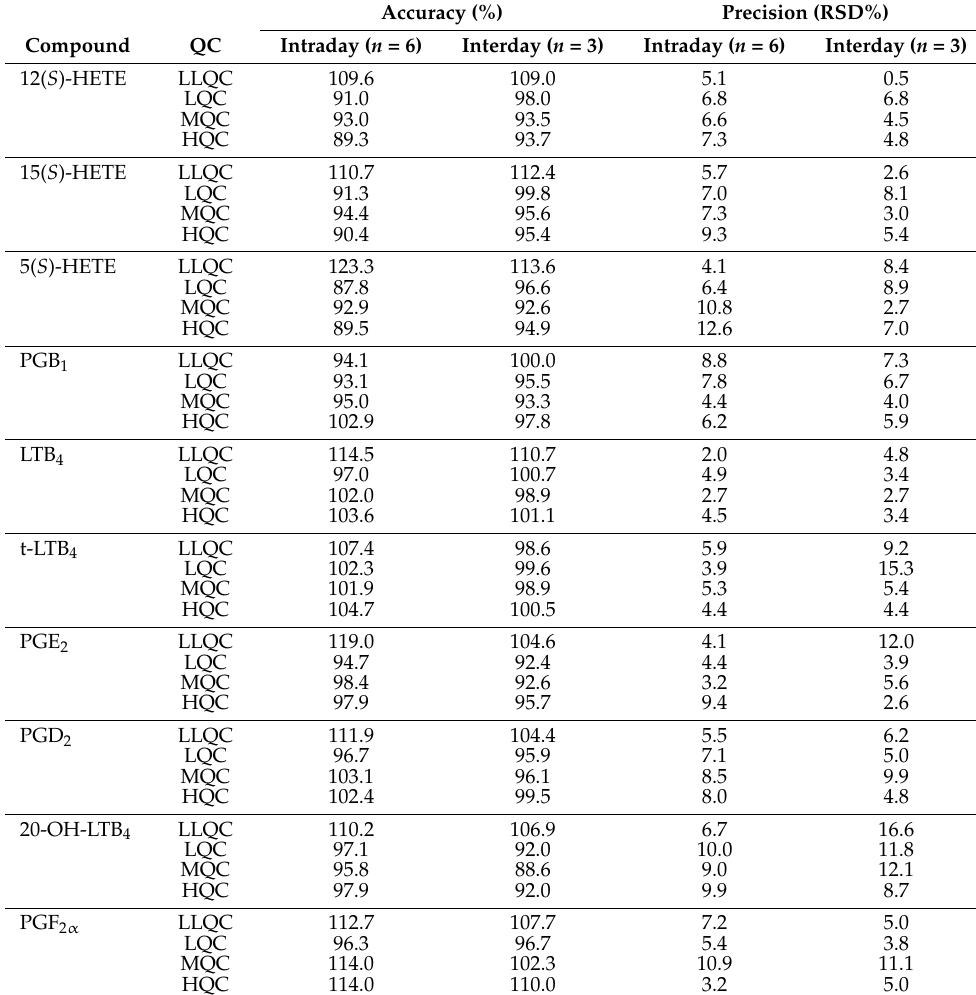
Table 2. Accuracy and precision of method validation. Accuracy is expressed as the percentage amount of added analyte to the blank. Precision is reported as the coefficient of variation. QC samples are MeOH spiked with all 11 eicosanoids at 4 different concentrations. Concentration